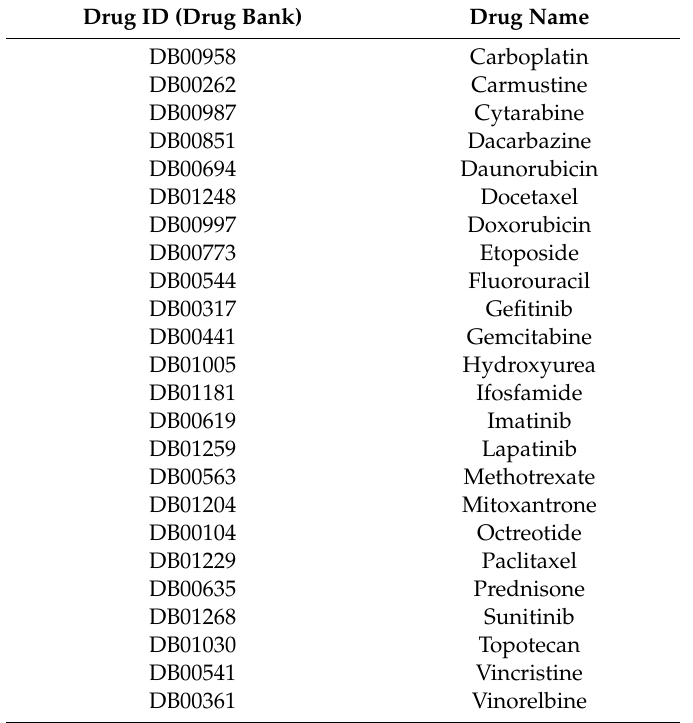
Table 2. Predicted drugs for